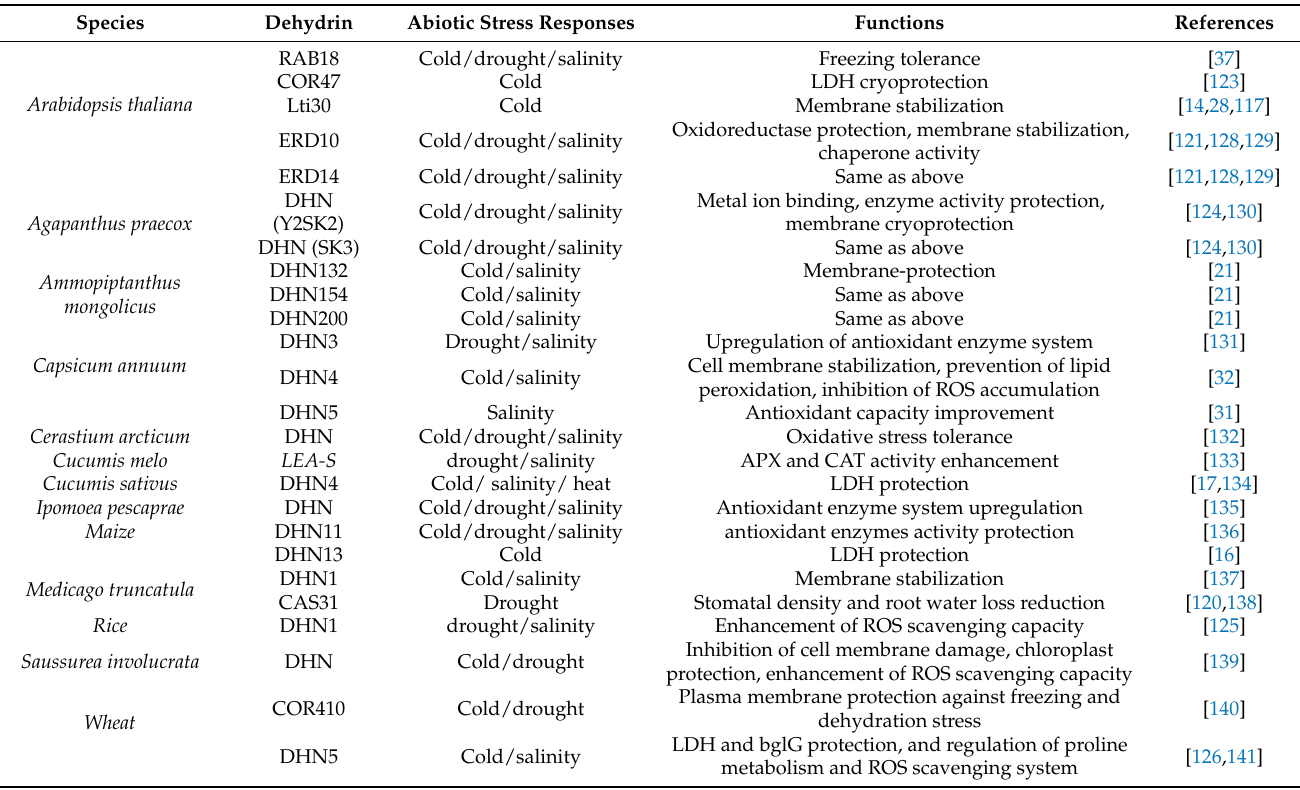
Table 1. Roles of dehydrins in abiotic stress tolerance in various plant